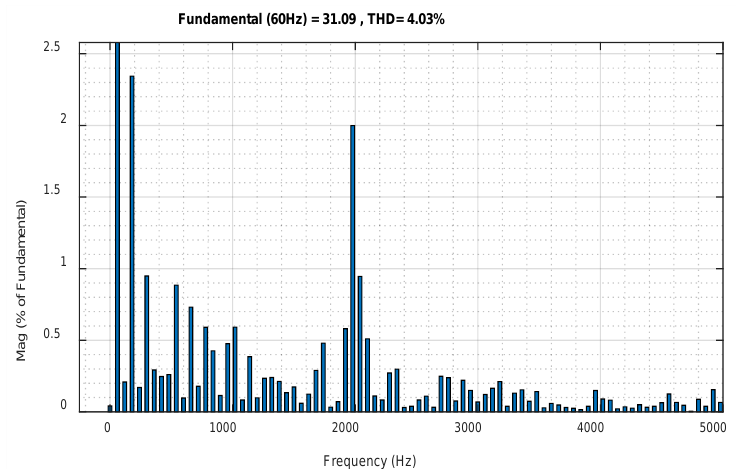
Figure 13. Load current THD spectrum using the traditional PWM method.